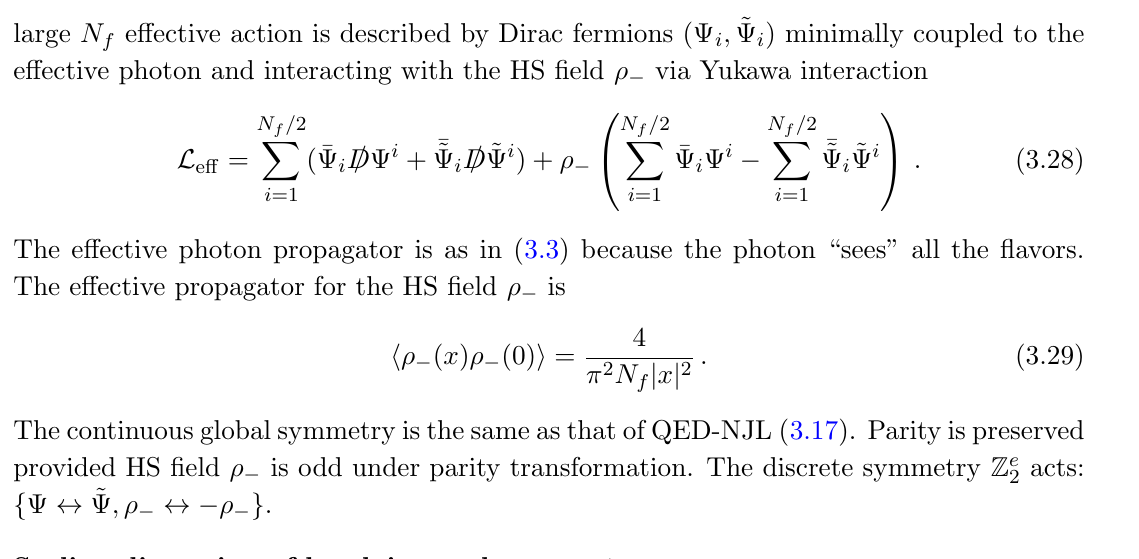
Table 12 . (QED-NJL) mixing of quadratic in HS (cid:12)eld